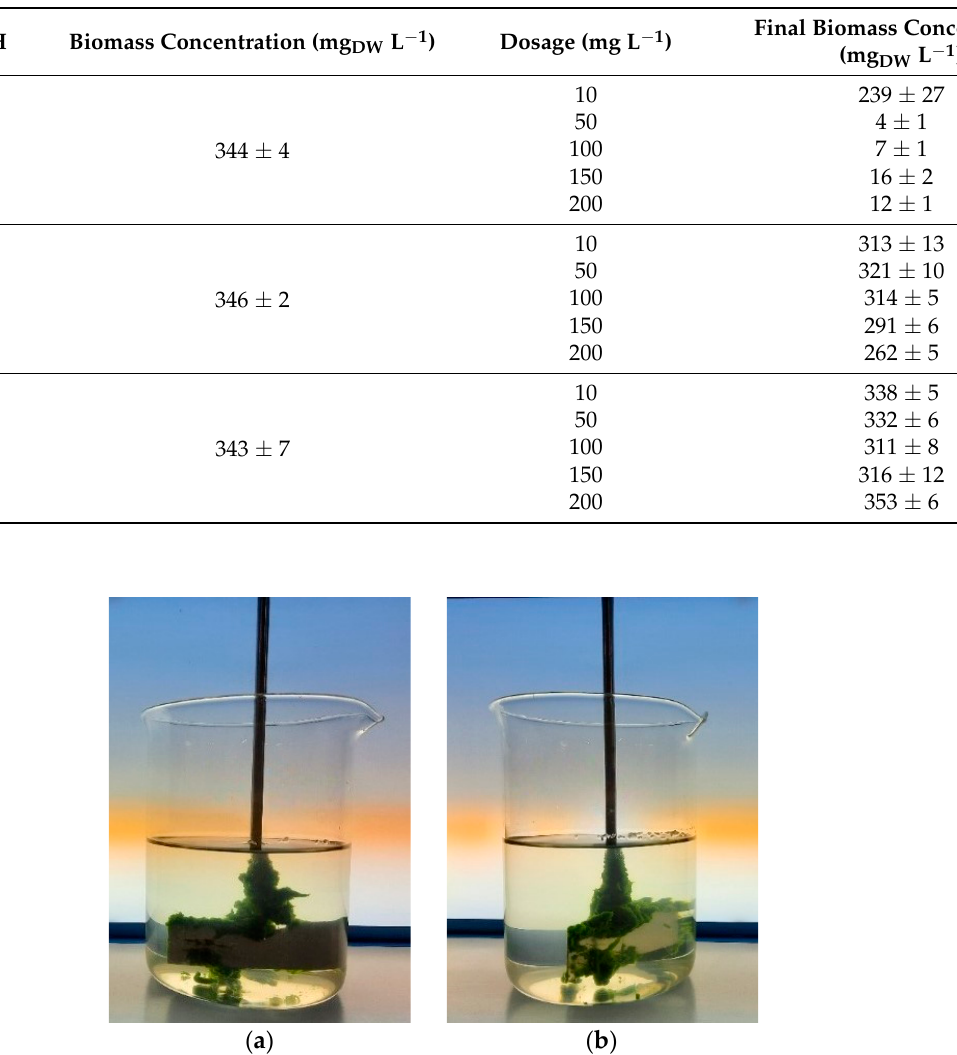
Table 3. Harvesting efficiency obtained in flocculation assays using concentrations of 10–200 mg L − 1 of Zetag 8485 at pH 6 and Tanfloc SG and ferric chloride at pH 9.